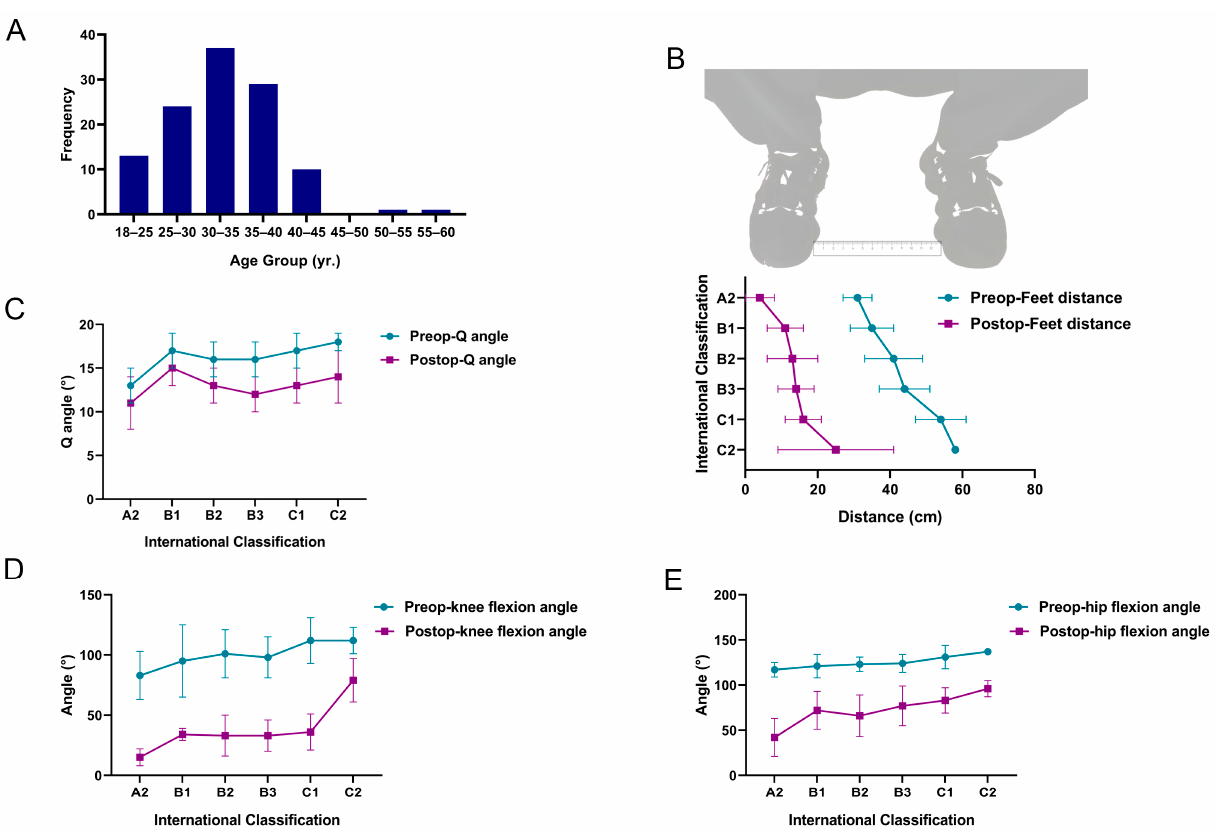
Figure 4. ( A ) During arthroscopic GMC release, severe contractures of the muscles and fascia could be seen under a microscope. ( B ) After surgery, the hip ROM was improved, and the patient could easily cross his legs and squat with both knees together.